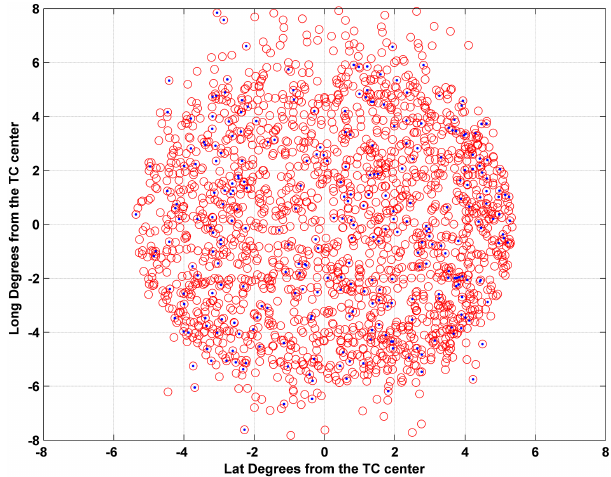
Figure 3. Exemplary distribution of GPS RO profiles within 6h (red circles) and 3h (blue dots) around the center of a tropical storm in the North Atlantic Ocean, within a spatial window of 600km from the